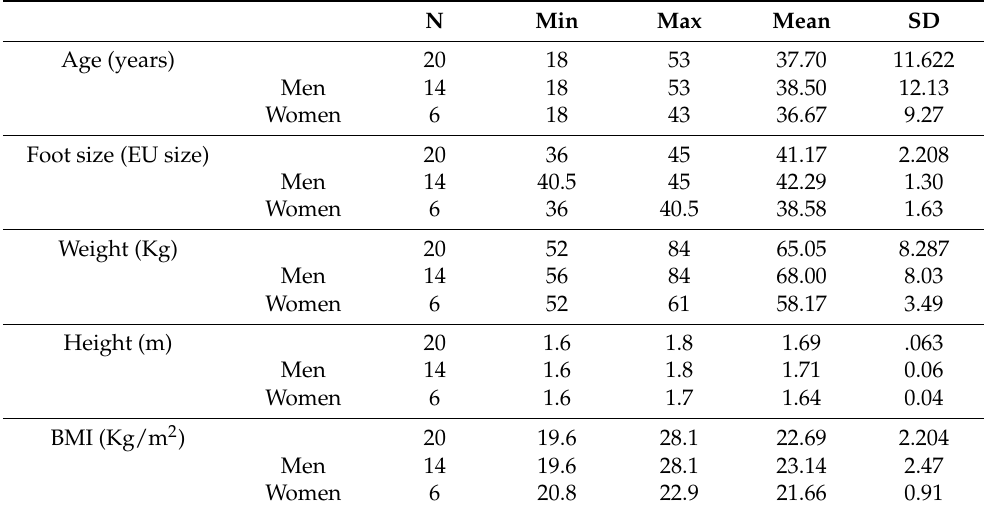
Table 1. Anthropometric characteristics of the whole sample and by